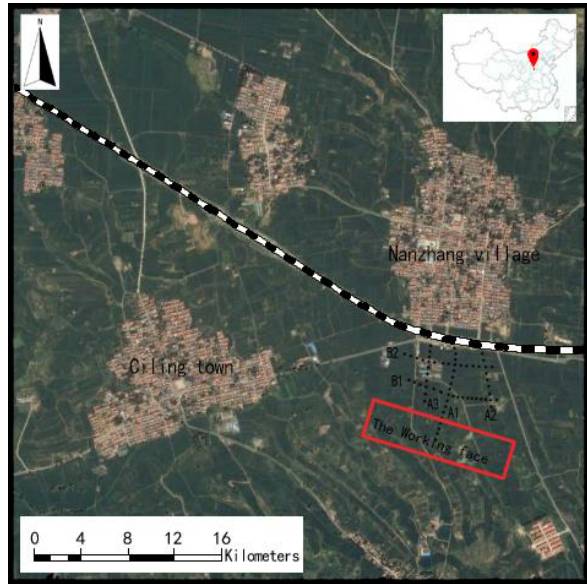
Figure 1. Location of the study area from google earth In this paper, a total of 10 Sentinel-1A images acquired from 2015/9/26 to 2016/5/23 are used for analysis. The polarization is VV. The incidence angle is 41.6°. The center latitude and longitude of the image is 36.05° and 112.95° respectively. The spatial baseline and temporal baseline is an important factor in choosing a suitable data pair. For these Sentinel-1A data, the largest perpendicular baseline is approximately 107m, which can avoid spatial decorrelation, the largest temporal baseline is 48 days which relatively prevent the decrease of the coherence of interferograms. Table 1 explains the acquisition data and baseline of the related images.